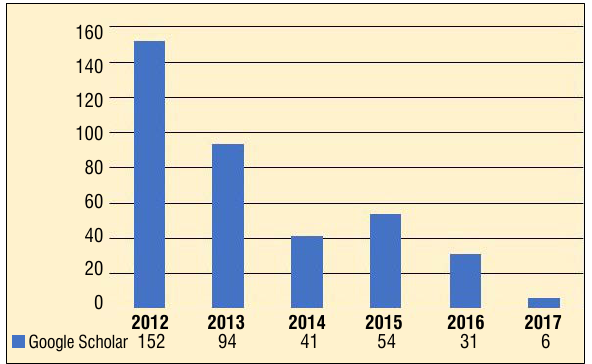
Figure 8: Number of citations to South African Journal of Libraries and Information Science according to Google